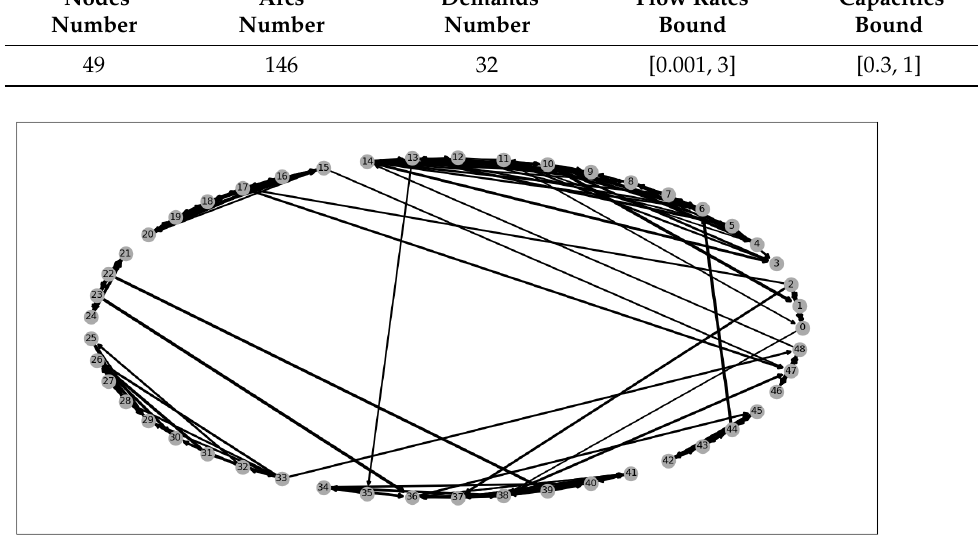
Figure 2. Large network